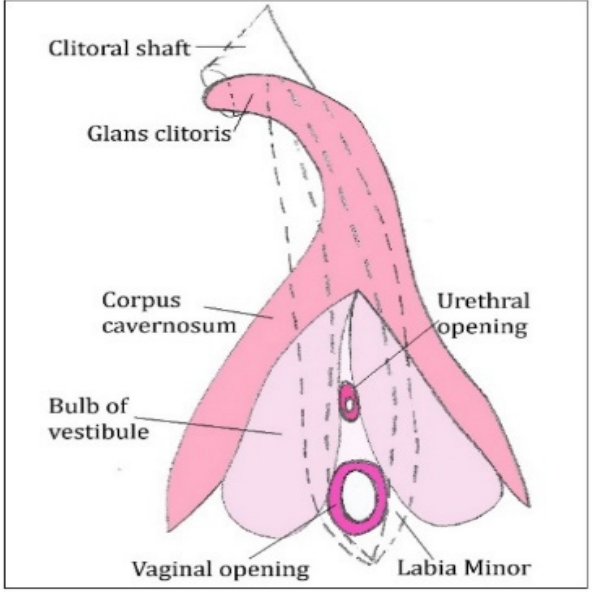
Figure 4. Clitoris morphology.